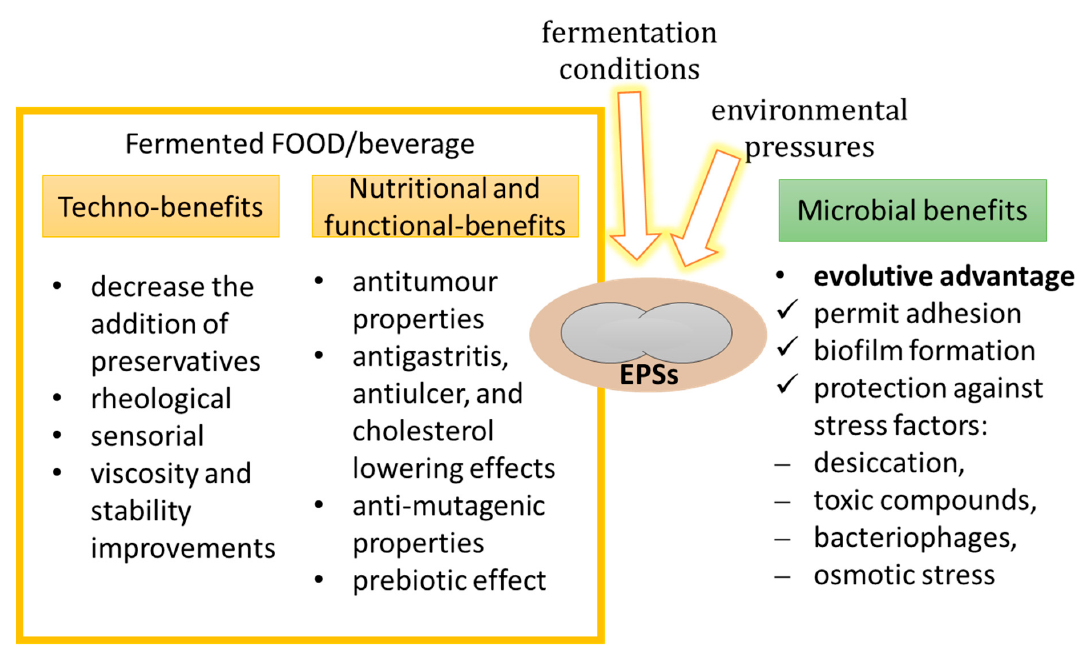
Figure 3. Microbial benefits due to EPS production for cell and key techno and functional roles of EPSs in food or beverages.